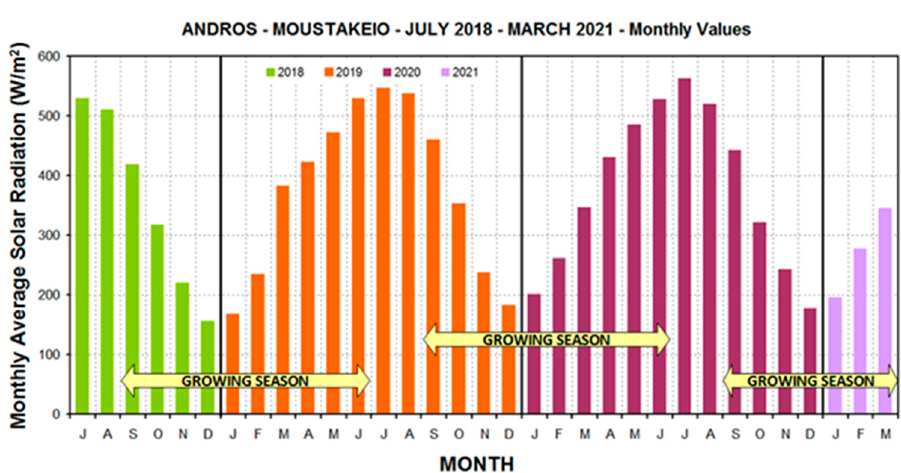
Figure 5. Average solar radiation (W/m 2 ) per month for three cultivating periods (2018–2021) in Andros Island.